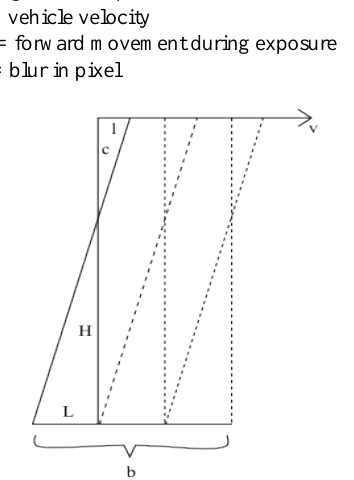
Figure 1. Sketch of image blur due to UAV movement. Not included are angular rotations which introduce a bigger blurring effect.